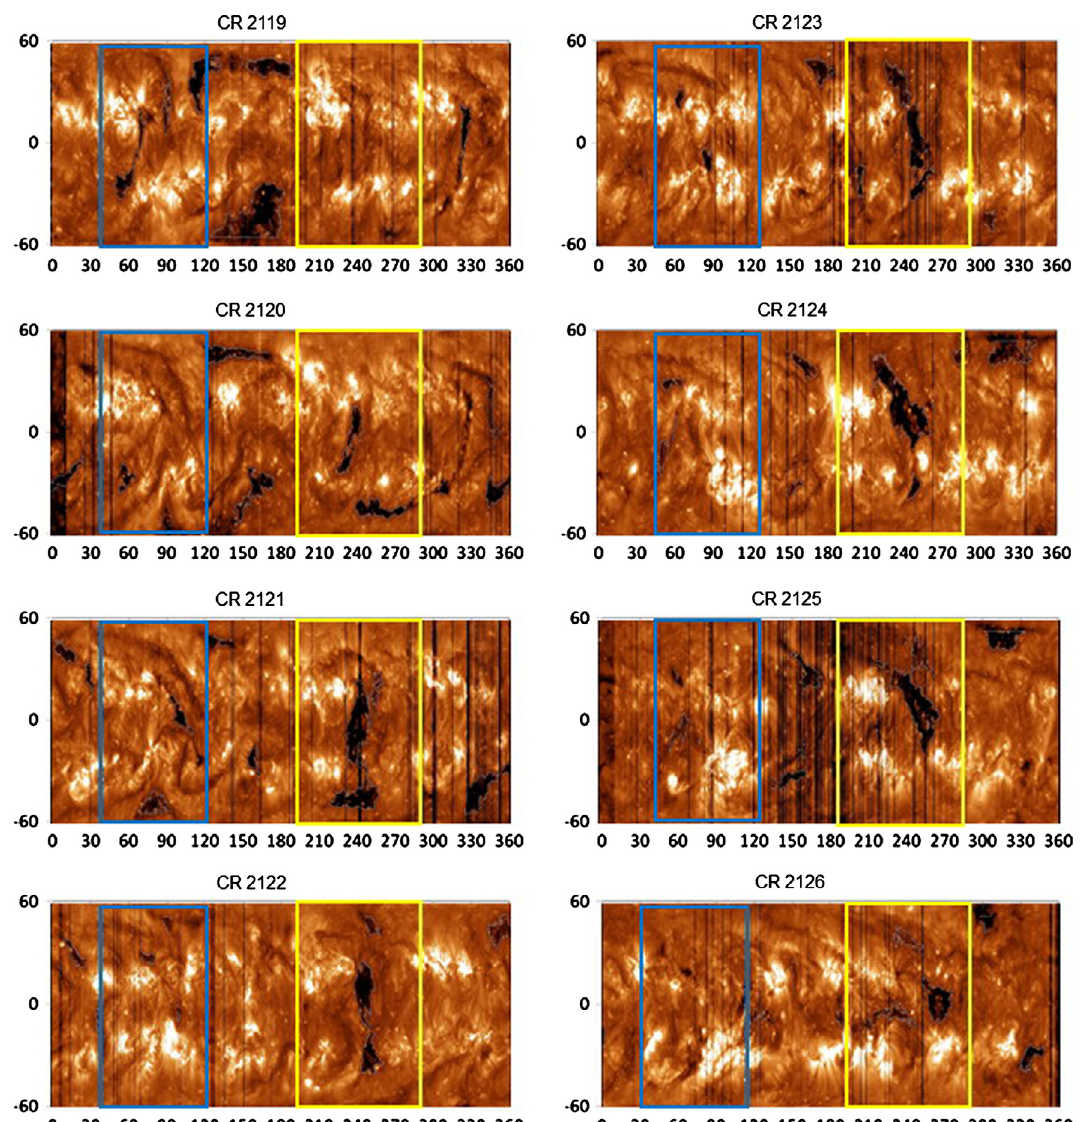
Figure 3. Synoptic maps constructed from the EUV images in the channels 193 A˚ obtained by SDO/AIA during the period from January to August, 2012 (CR 2119–2126). The LCH located in one of the negative polarity regions of the coronal magnetic field is shown inside the yellow frame. Small CHs located in other negative polarity region are shown inside the blue